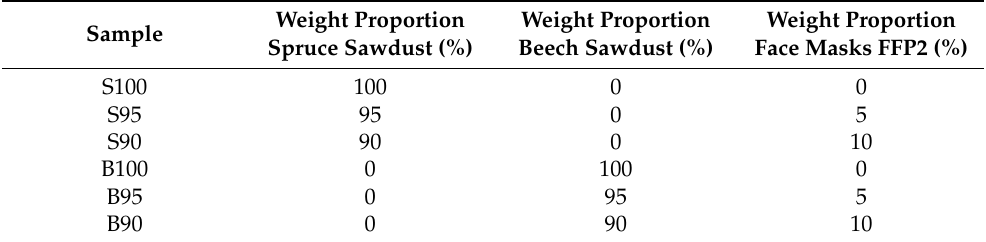
Table 1. Created